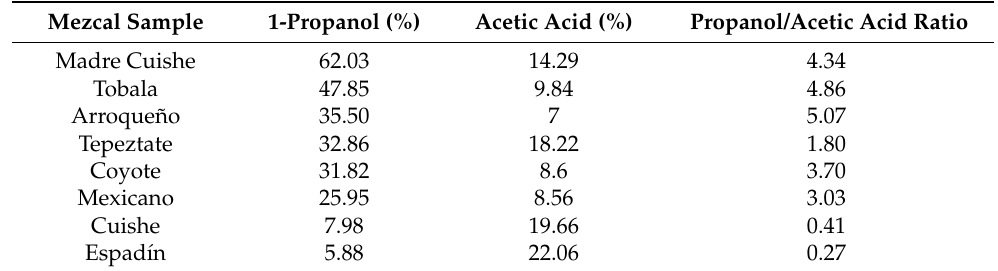
Table 2. Ratio of the relative abundances of 1-propanol and acetic acid in mezcal